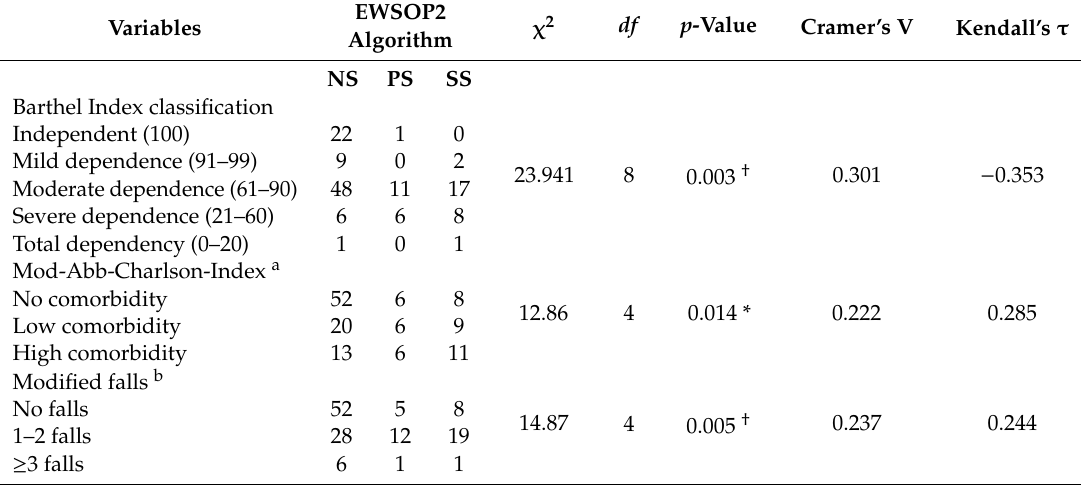
Table 3. Number of cases (n) and Chi-squared results of the independent variables.